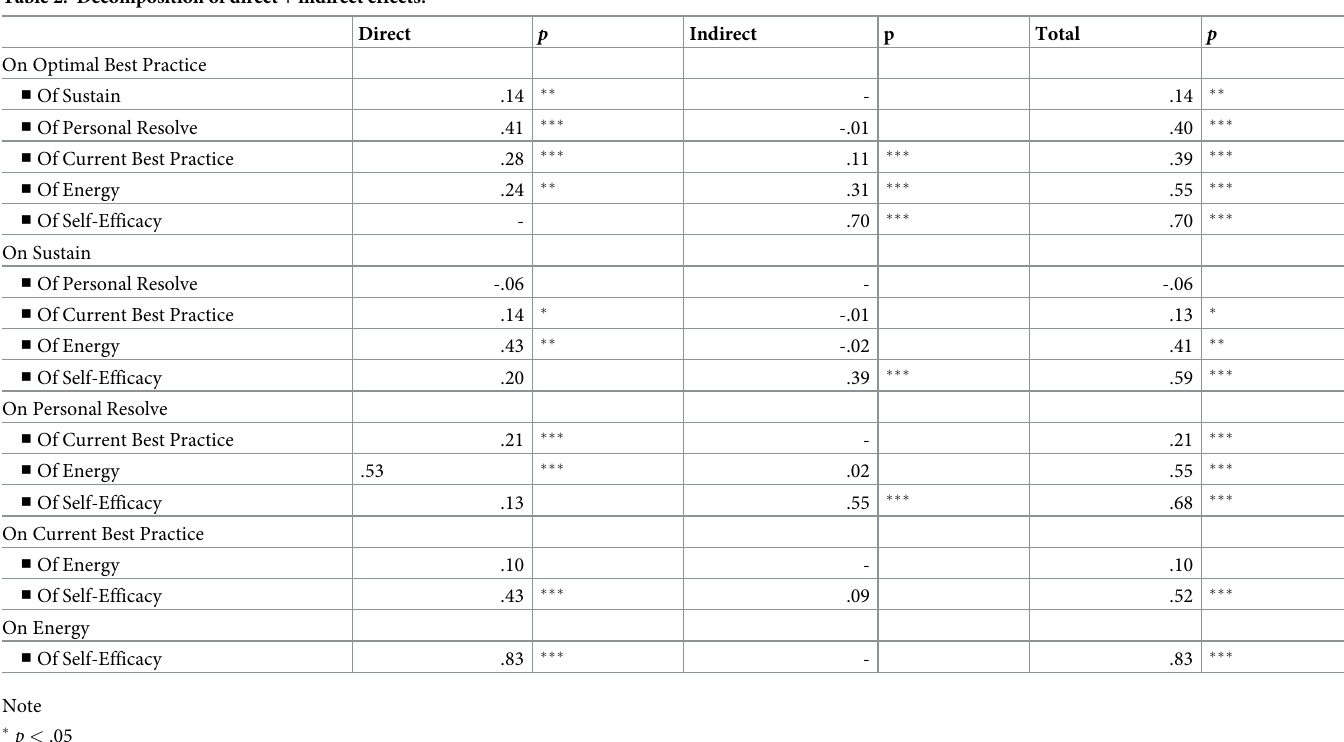
Table 2. Decomposition of direct + indirect